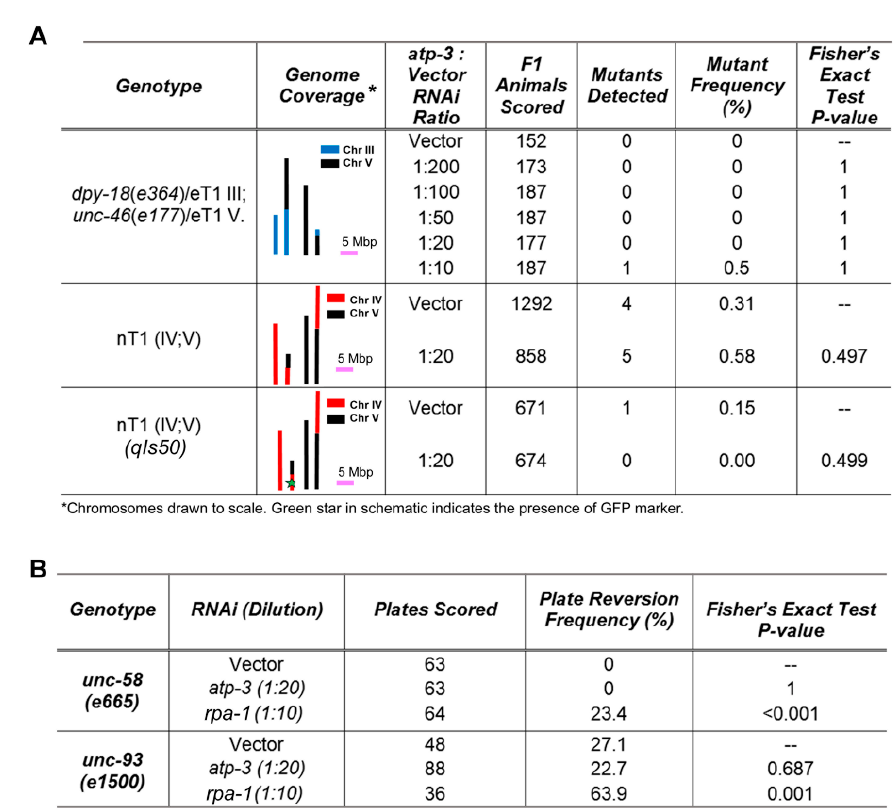
Figure 4. Nuclear DNA mutation rate is not increased following mitochondrial ETC disruption .